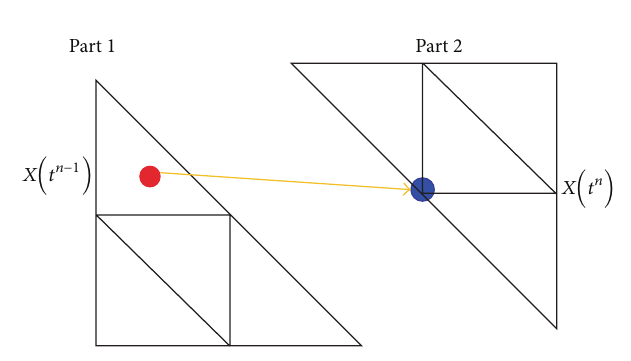
Figure 2: Searching over parts.